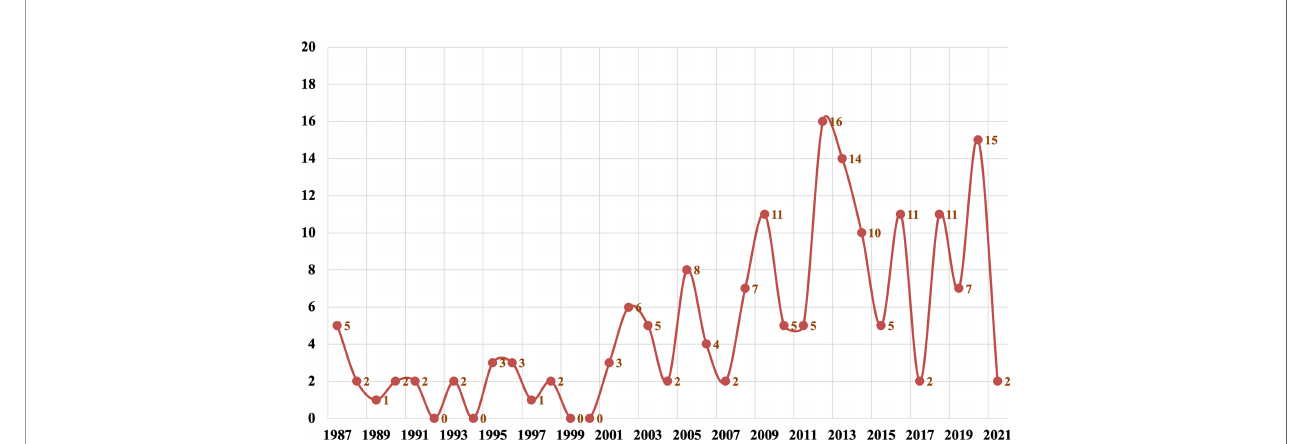
FIGURE 1 | The number of reported cases of PHM in